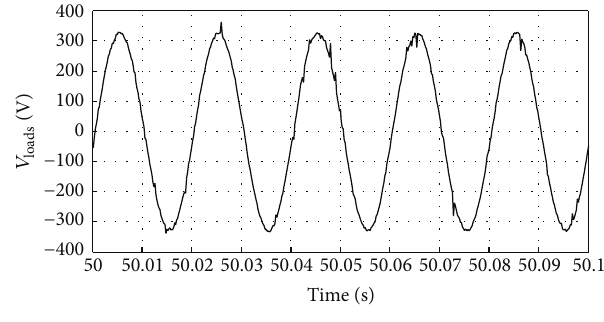
Figure 27: Wave shape of the voltage on loads.